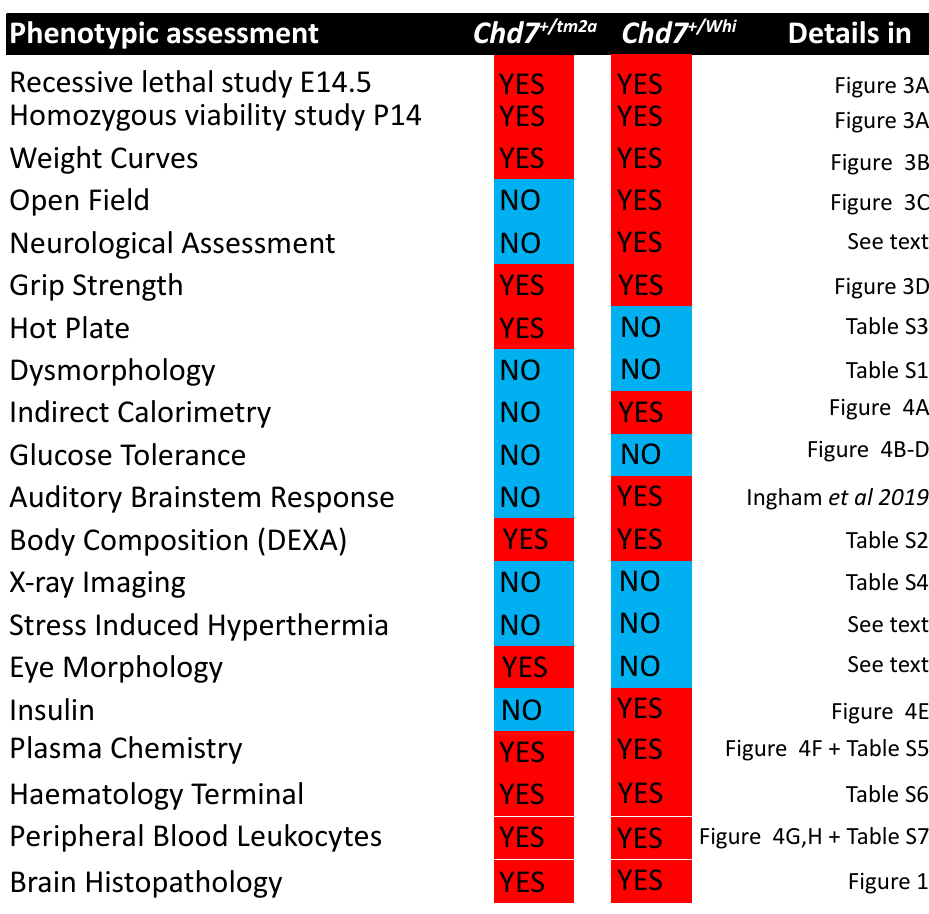
Figure 2. Result summary of phenotypic screen. Yes/red indicates significant threshold reached in the specified parameter. No/blue indicates normal phenotypes relative to respective line controls. The last column indicates where the detailed analyses are (figure, tables or references as